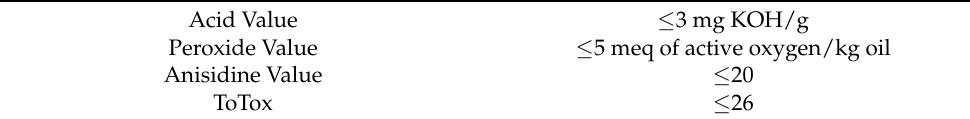
Table 1. Oxidation quality parameters 1